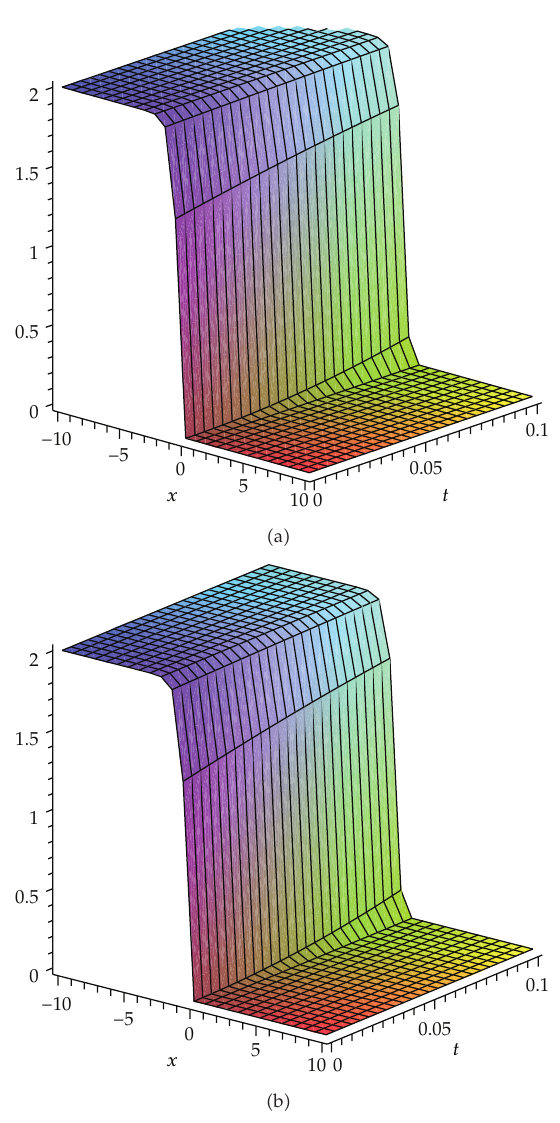
Figure 3: The solution of (cid:3) 1.1 (cid:4) at c (cid:9) 2 (cid:3) a (cid:4) HPM (cid:3) b (cid:4)